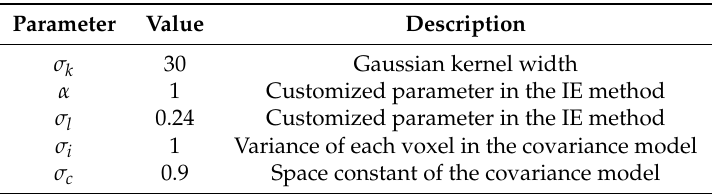
Table 1. Parameters used in the experiment.